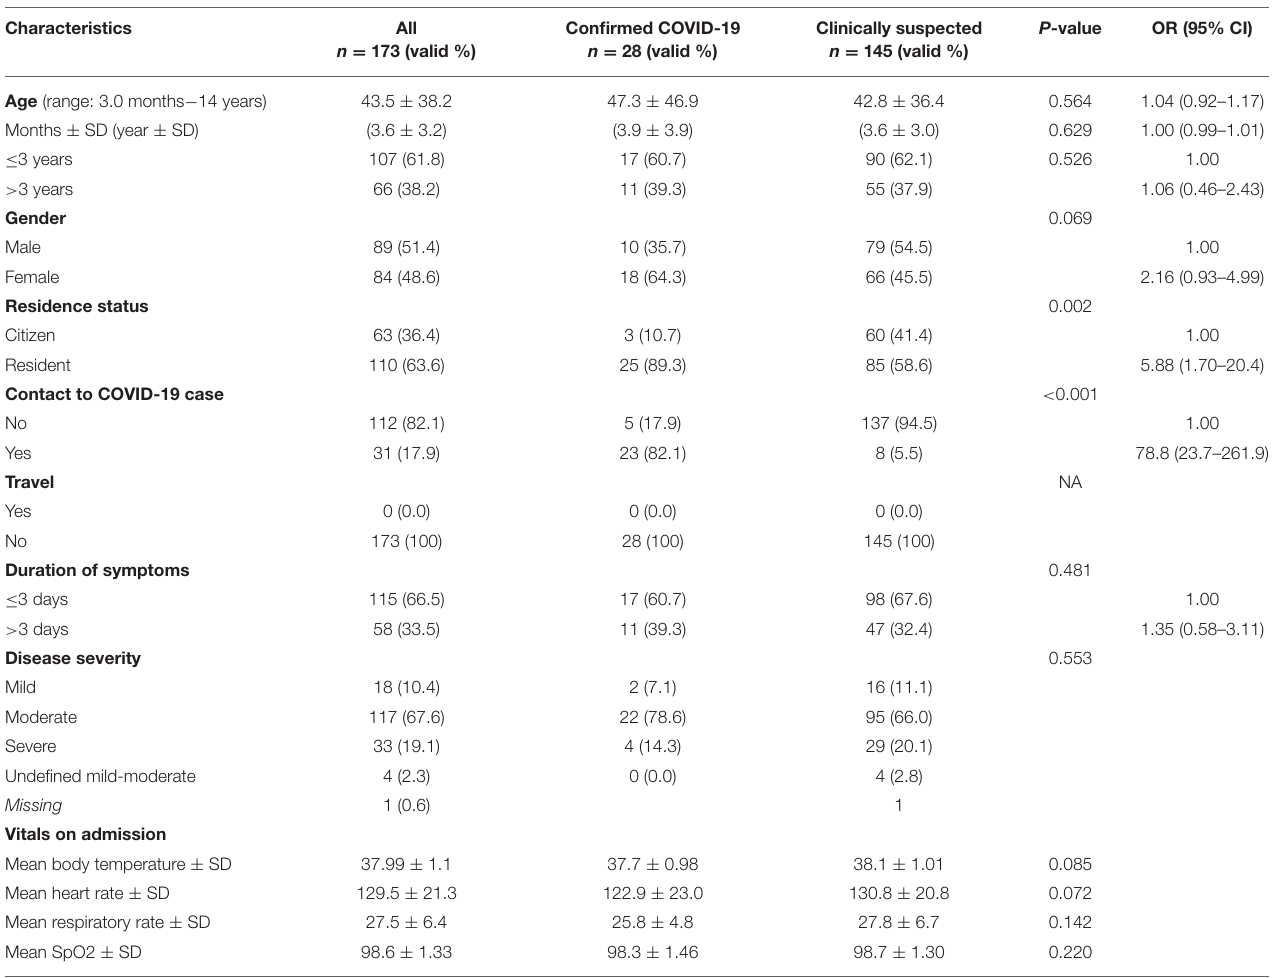
TABLE 1 | Distribution of confirmed (RT-PCR-positive) and clinically suspected (RT-PCR-negative) COVID-19 pediatric patients according to their sociodemographic and medical characteristics factors associated with RT-PCR-positive patients.